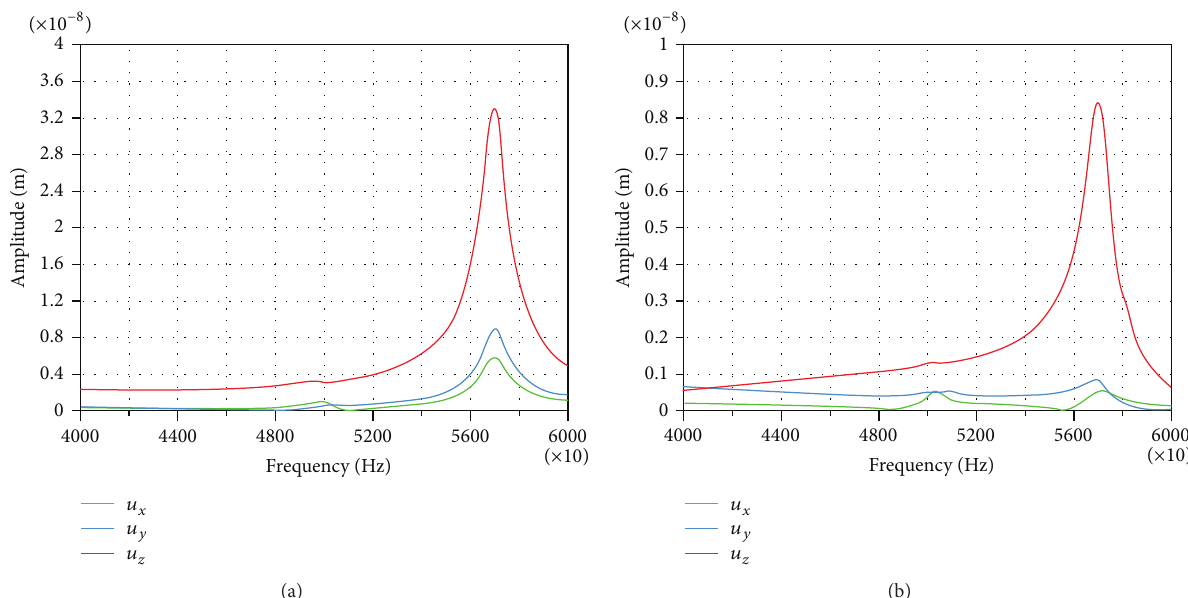
Figure 5: The amplitude-frequency characteristic of the contact point oscillation at three-phase excitation with 𝐴 = 100V: symmetrical waveguide (a), asymmetrical waveguide